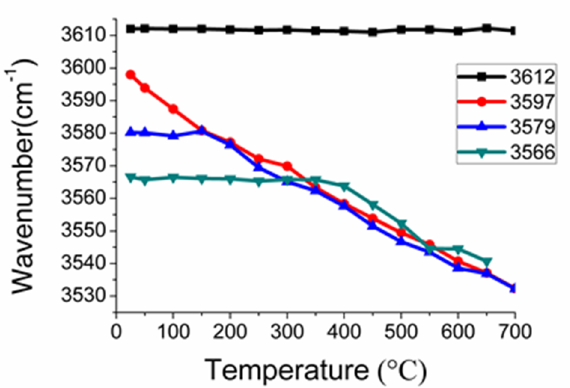
Figure 11. IR spectra change in shape and position of the OH absorptions with temperature (infrared light perpendicular to (010), electric vector E of the light wave is parallel to [100]).